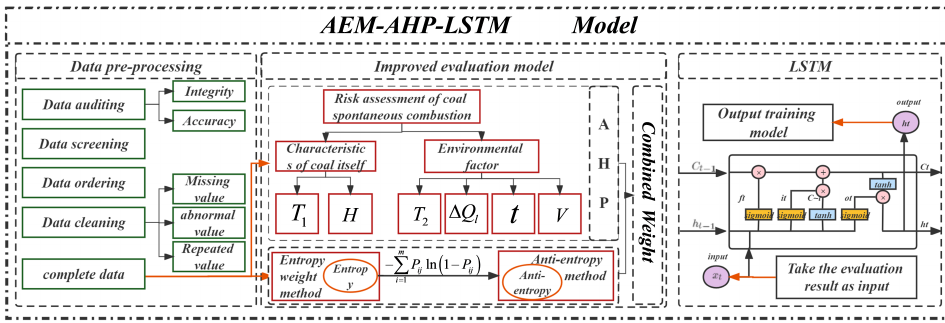
Figure 3. AEM-AHP-LSTM model flow